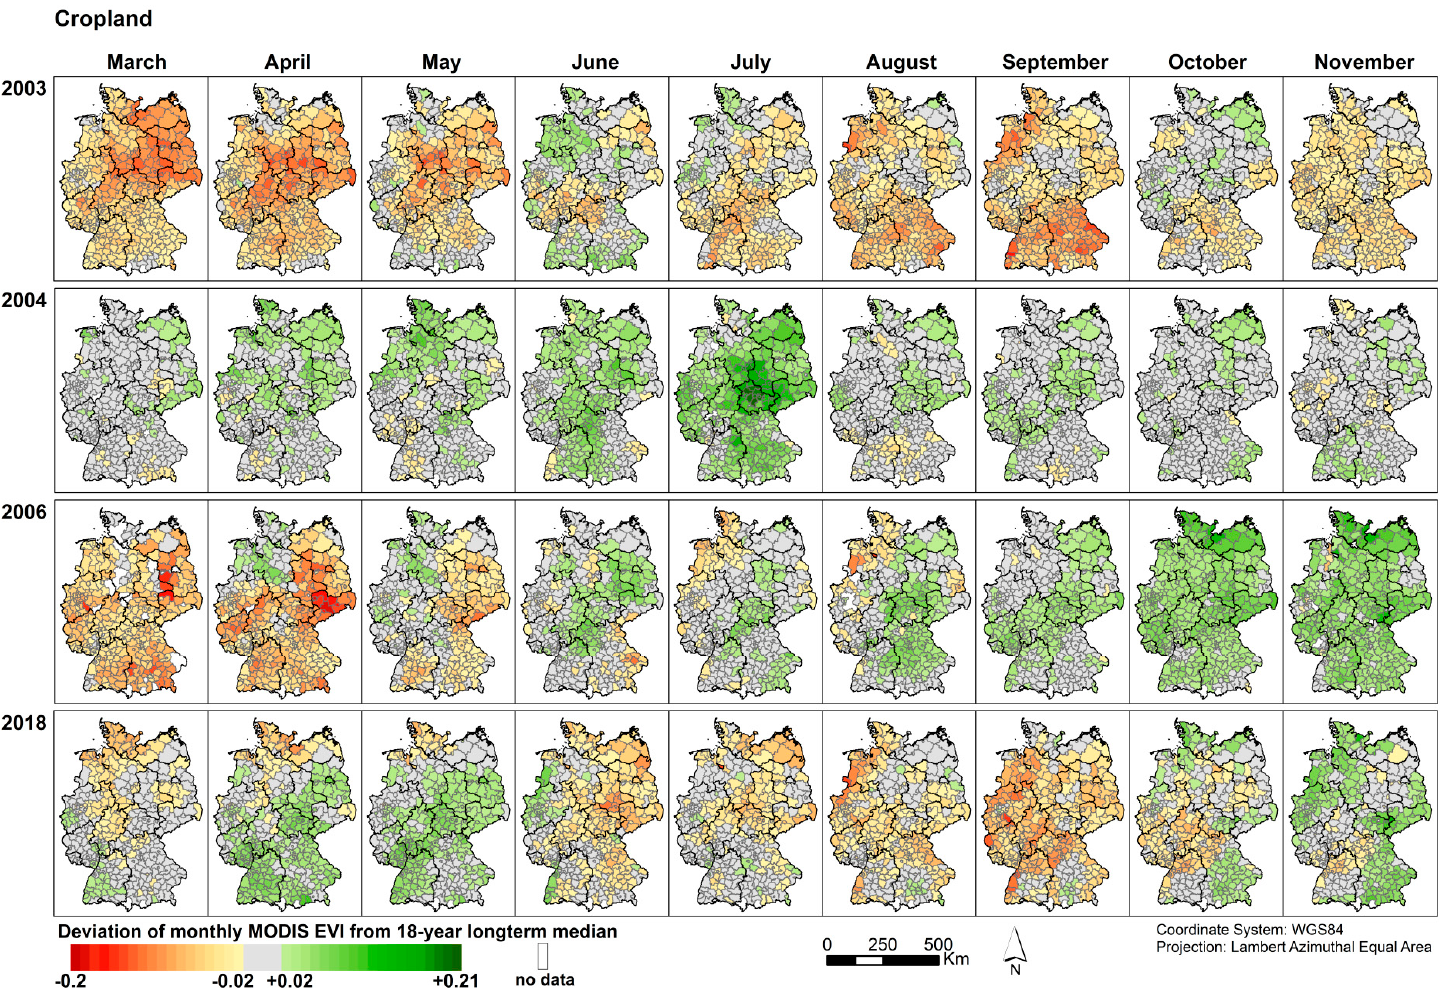
Figure 8. County level monthly EVI anomalies for the vegetation period of four years, including only croplands. Counties comprising less than 10 valid pixels are excluded and are shown as no data class.